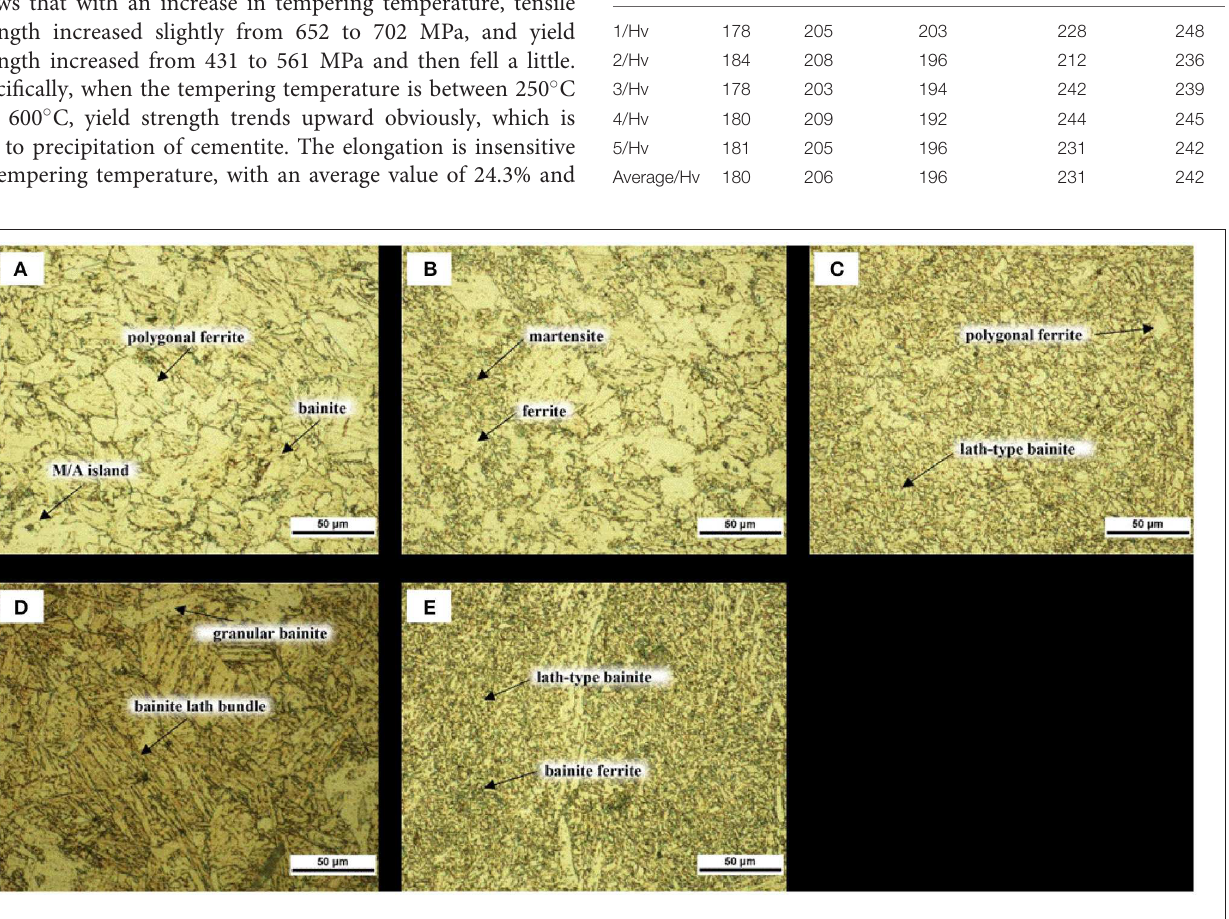
Frontiers in Materials |